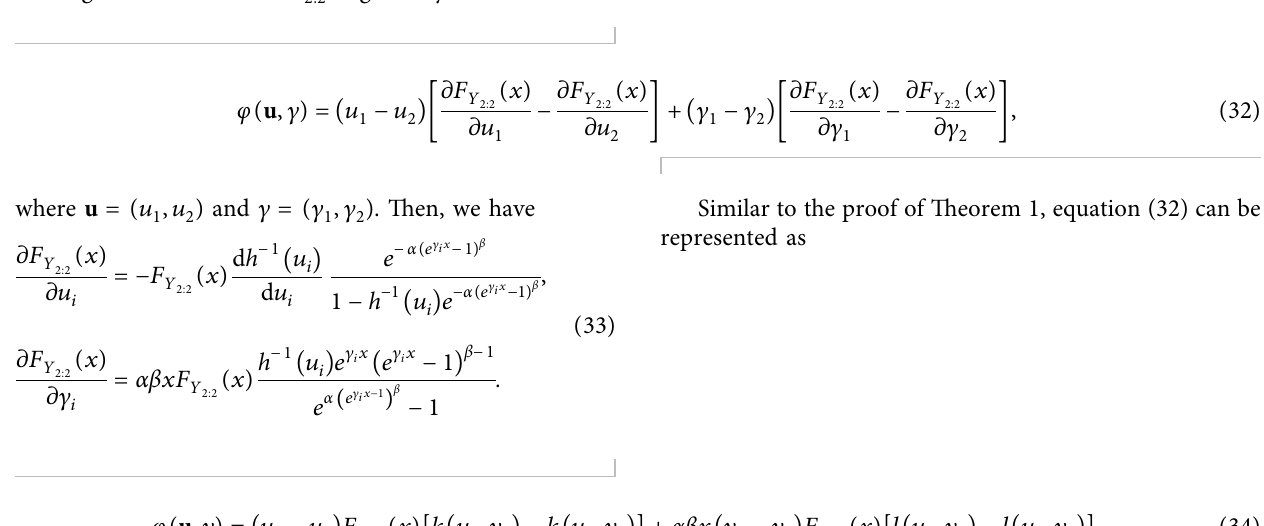
Figure 1: (a) Plot of the difference functions F and u ∈ ( 0 , 1 ]